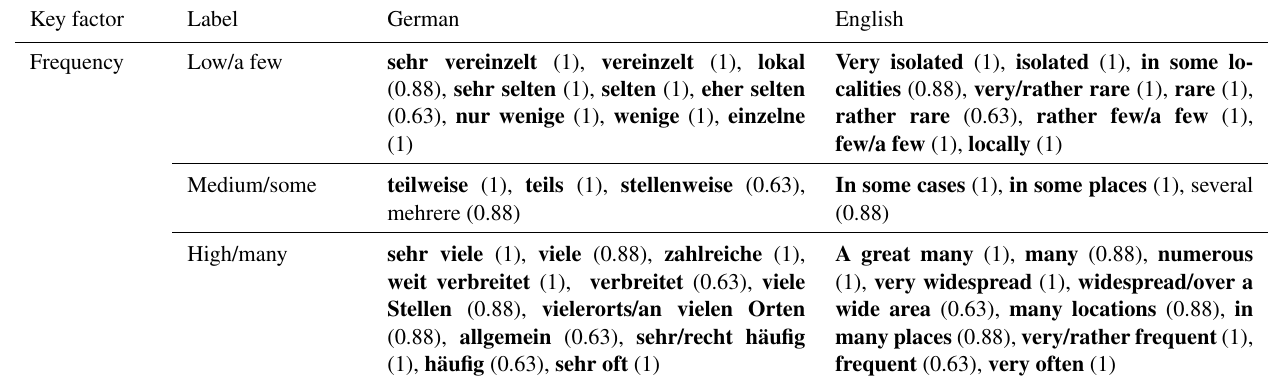
Table A3. Labels assigned to German text values describing the frequency of potential triggering spots or the number of avalanches, including the proportion of forecasters who assigned the respective label to this value (in brackets) and their corresponding English translations. Note that the proportions shown in the English column are indications only as many-to-one and one-to-many translations were possible (i.e., one English translation for two German words or vice versa). Bold – value was used during the 8